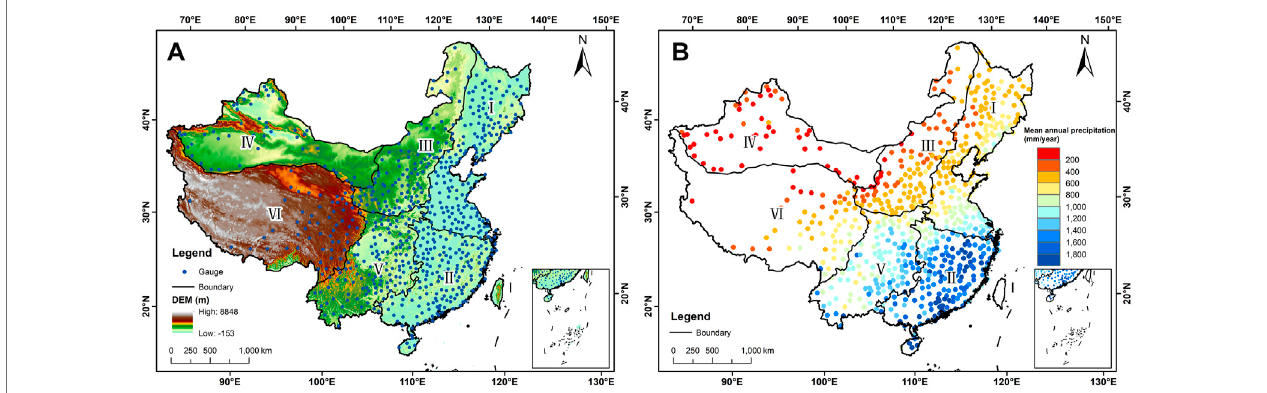
FIGURE 1 | Study area information. (A) Meteorological stations and topography. (B) Mean annual precipitation.